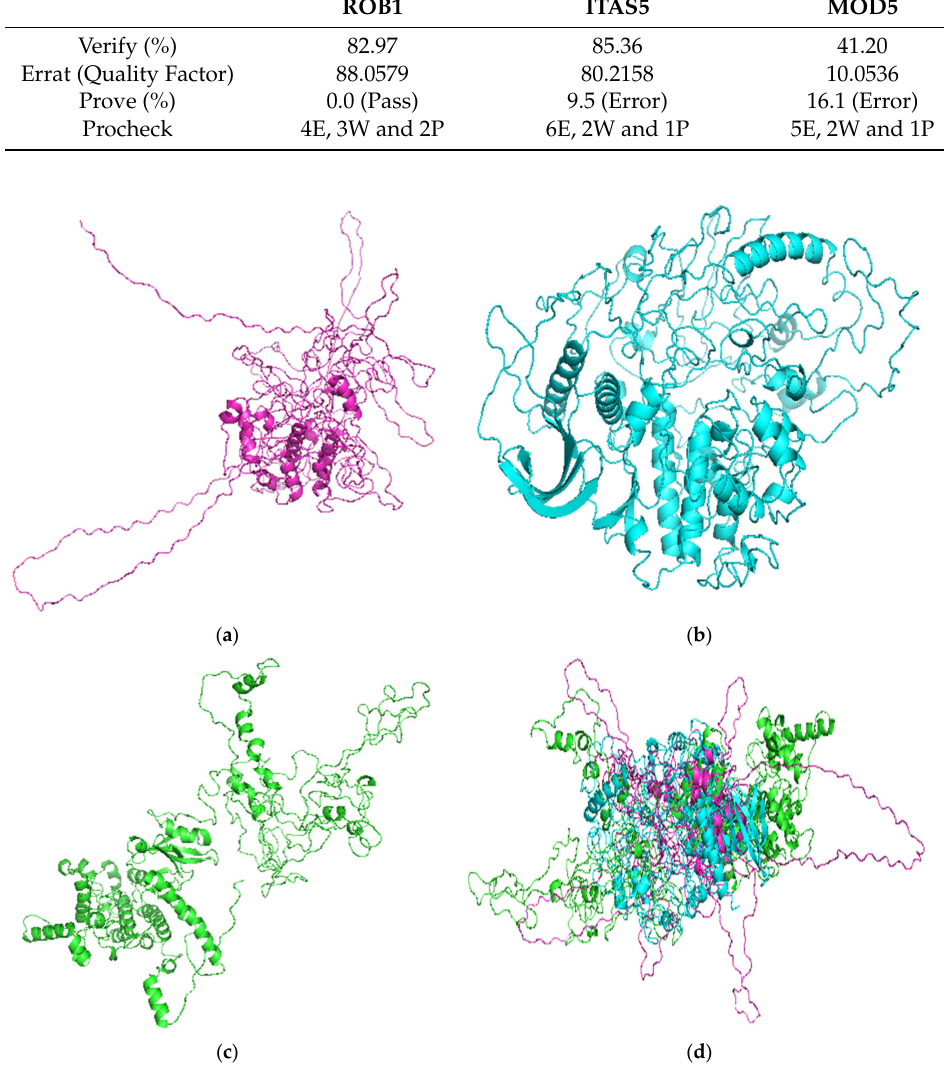
Figure 2. Cartoon views of the top 3 predicted tertiary structures of the Ld CRK12 from the 3 techniques used: ( a ) MOD5; ( b ) ITAS5; ( c ) ROB1; and ( d ) top 3 models aligned. MOD5, ITAS5, and ROB1 are colored in magenta, cyan and green,